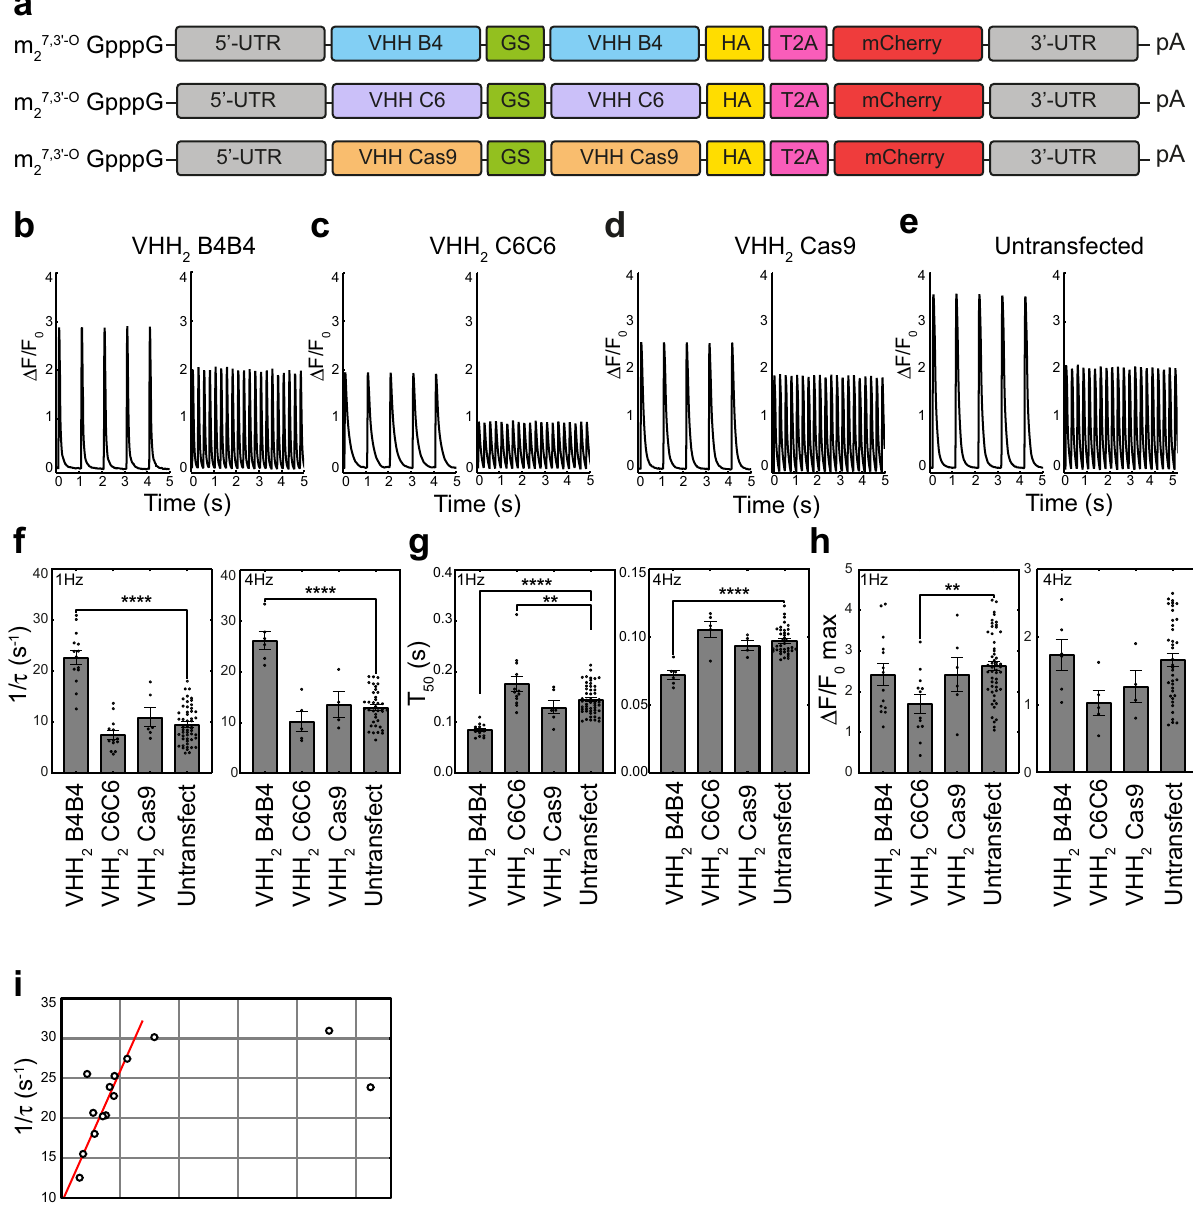
Fig. 5 Effects of modRNA mediated intrabody expression on calcium cycling in adult cardiomyocytes. a modRNA construct design. m 2 7,3'-O GpppG is the ARCA CAP; 3 ’ UTR is the 3 ’ untranslated region, VHH is the intrabody encoding sequence, GS is a sequence that encodes a glycine-serine linker peptide (GGGSGGGSGGGSGGGS), HA is the sequence that encodes the hemagglutinin tag, T2A is the T2A peptide encoded sequence, mCherry is the mCherry sequence, 5 ’ UTR is the 5 ’ untranslated region and pA is the poly-A tail. b – e Representative Ca 2 + transients of each of the groups at 1 Hz and 4 Hz (VHH 2 B4B4: n = 14 at 1 Hz, n = 6 at 4 Hz; VHH 2 C6C6: n = 13 at 1 Hz, n = 5 at 4 Hz; VHH 2 Cas9: n = 6 at 1 Hz, n = 4 at 4 Hz; untransfected cells: n = 52 at 1 Hz, n = 38 at 4 Hz) b cells transfected with modRNA encoding for VHH 2 B4B4, c cells transfected with modRNA encoding for VHH 2 C6C6, d cells transfected with modRNA encoding for VHH 2 Cas9, e Untransfected cells. f – h Individual data points (open circles) and average value (bar graph) for the parameters for 1/ τ (rate of transient decay), T 50 (50% time elapse or (Ca 2 + transient width) and peak height Δ F / F 0 max (Ca 2 + transient amplitude) (VHH 2 B4B4: n = 14 at 1 Hz, n = 6 at 4 Hz; VHH n = 13 at 1 Hz, n = 5 at 4 Hz; VHH n = 6 at 1 Hz, n = 4 at 4 Hz; untransfected cells: n = 52 at 1 Hz, n = 38 2 C6C6: 2 Cas9: at 4 Hz). Statistical signi fi cance between groups was evaluated using one-way ANOVA and two-tailed Tukey-Kramer post-hoc tests assuming normal distribution. Error bars represent the standard error of the mean (SEM). Signi fi cance levels for differences of treated groups with the control group (untransfected cells) are indicated: ** P -value < 0.01, **** P -value < 0.0001. i Scatter plot of the 1/ τ (rate of Ca 2 + transient decay) values for VHH 2 B4B4- T2A-mCherry transfected cardiomyocytes vs mCherry intensity. A linear regression trend line through the fi rst 5 points is shown as a dotted line. A.U. arbitrary units. Source data are provided as a Source Data fi